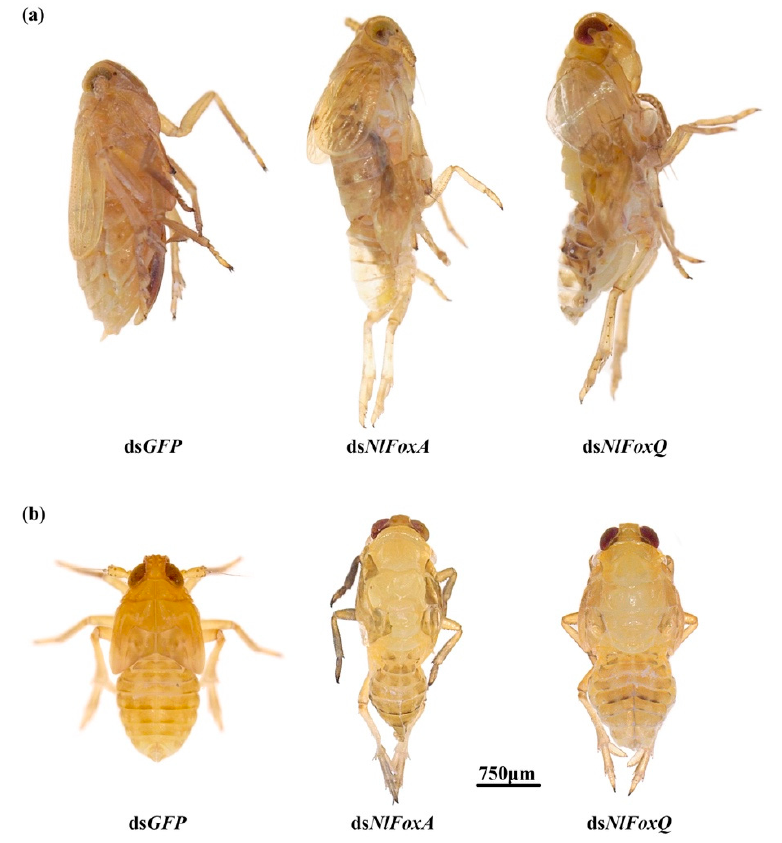
Figure 4. The lethal phenotypes of insects injected with dsRNA for N. lugens Fox genes. ( a ) DsRNA for NlFoxA or NlFoxQ (50 ng per insect; n = 100) was injected into BPHs at the very beginning of the fifth instar; ( b ) dsRNA for NlFoxA , NlFoxN1 or NlFoxQ (50 ng per insect; n = 100) was injected into BPHs at the very beginning of the fourth instar. Ds GFP was injected as a negative control for the nonspecific effects of dsRNA.